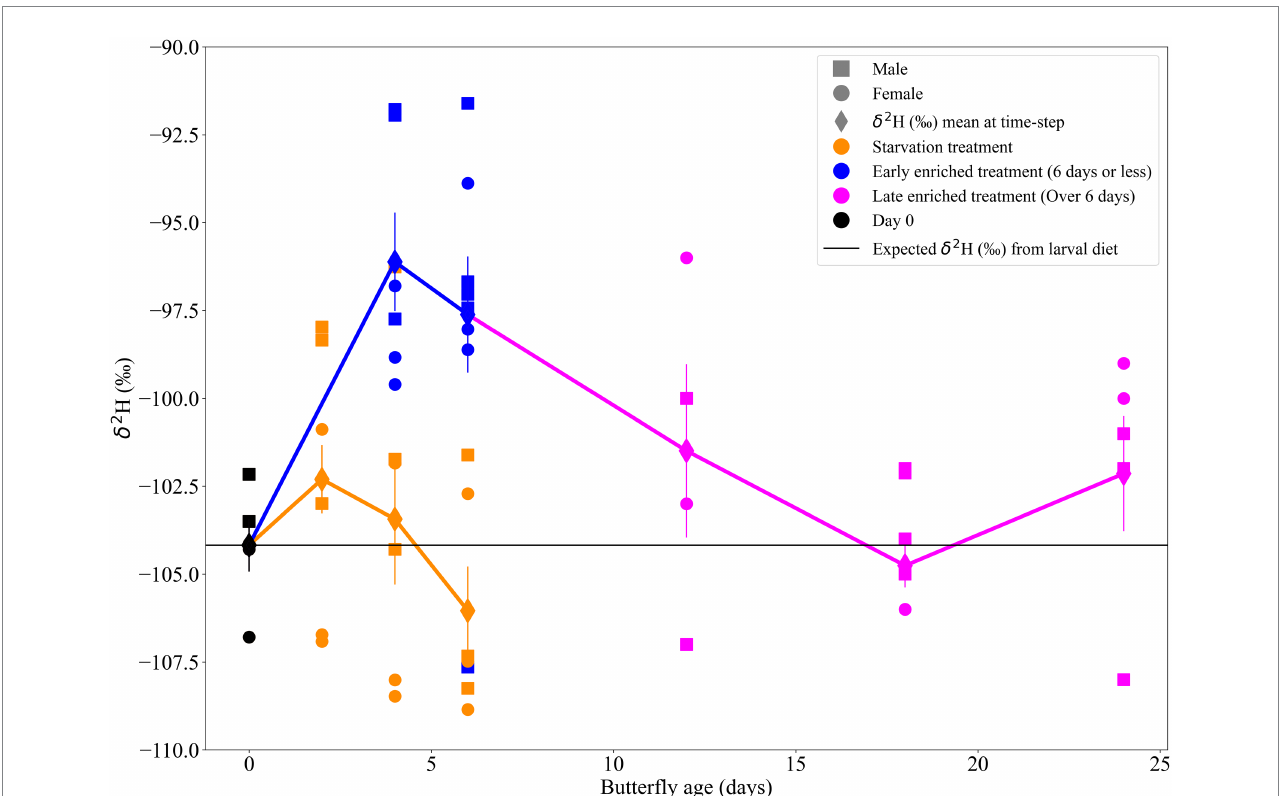
FIGURE 3 Scatter plot of δ 2 H (‰) of wing samples (from location S), shown over butterfly age (days) depicted by sex and adult dietary treatments (starvation and enriched) which are organised into four categories [(1) starvation, n = 19; (2) early enriched, n = 14; (3) late enriched, n = 15; and (4) day 0, n = 5]. The trendlines show the mean δ 2 H values of the two adult dietary treatments over butterfly age. The error bars represent the standard error of the mean for each treatment on a specific day. The horizontal line at − 104‰ depicts the day 0 δ 2 H mean, which is assumed to be the δ 2 H reflecting that of larval stages with no influence from adult diet or